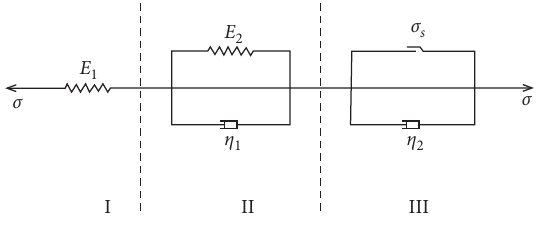
Figure 1: Components of Nishihara model.